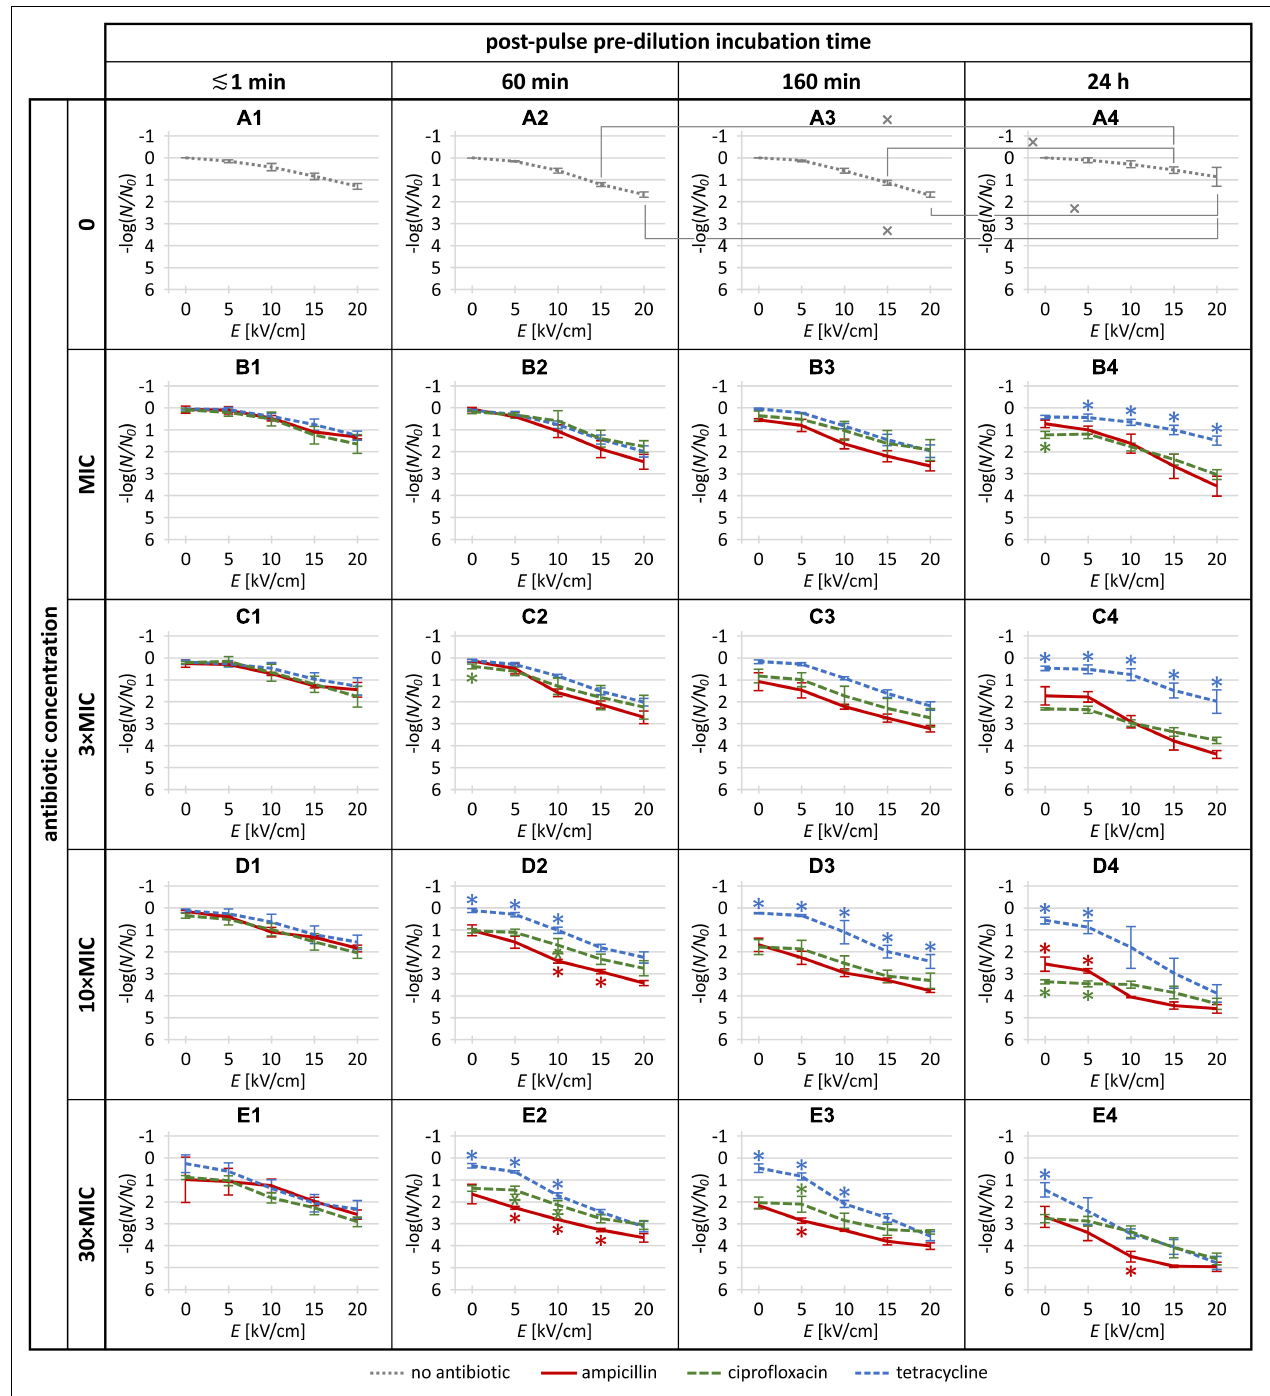
FIGURE 2 | The Escherichia coli inactivation rates in the absence of antibiotics (gray dotted) and for each of the three investigated antibiotics (red solid: ampicillin; green long-dashed: ciprofloxacin; blue short-dashed: tetracycline) at the MIC, 3 × MIC, 10 × MIC, and 30 × MIC, combined with a single 1-ms electric pulse at amplitude ( E ) of 0 (i.e., no pulse), 5, 10, 15, and 20 kV/cm. The plot labels (A1–E4) are provided to facilitate the referencing of individual plots in the body text. Each data point is represented as mean ± standard deviation of 3 replicates. In panels (A1–A4) , tilted crosses ( × ) mark pairs of data points where the inactivation rate achieved with the same pulse amplitude was statistically significantly different ( p < 0.05) for different incubation times. In panels (B1–E4) , asterisks ( ∗ ) mark data points where the inactivation rate was statistically significantly different ( p < 0.05) for one antibiotic versus both others (red ∗ : ampicillin vs. both ciprofloxacin and tetracycline; green ∗ : ciprofloxacin vs. both ampicillin and tetracycline; blue ∗ : tetracycline vs. both ampicillin and ciprofloxacin). Raw data and further statistical analysis are provided in the Supplementary Material .